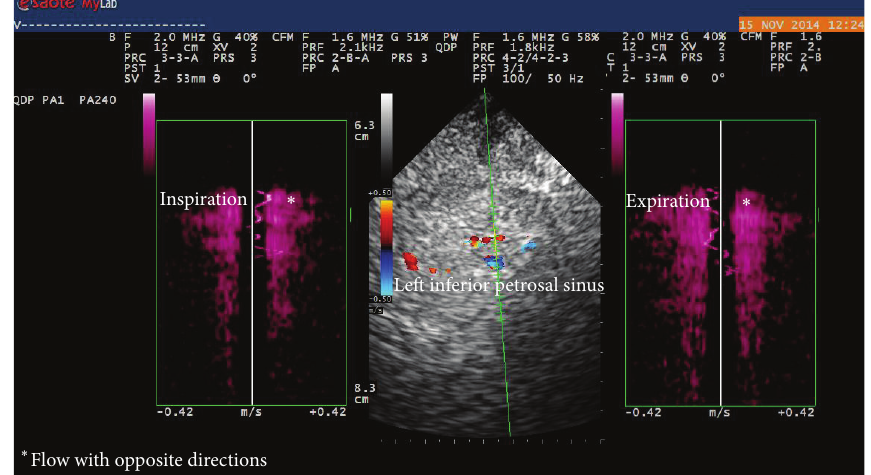
Figure 4: Reflux ( ∗ ) in the left inferior petrosal